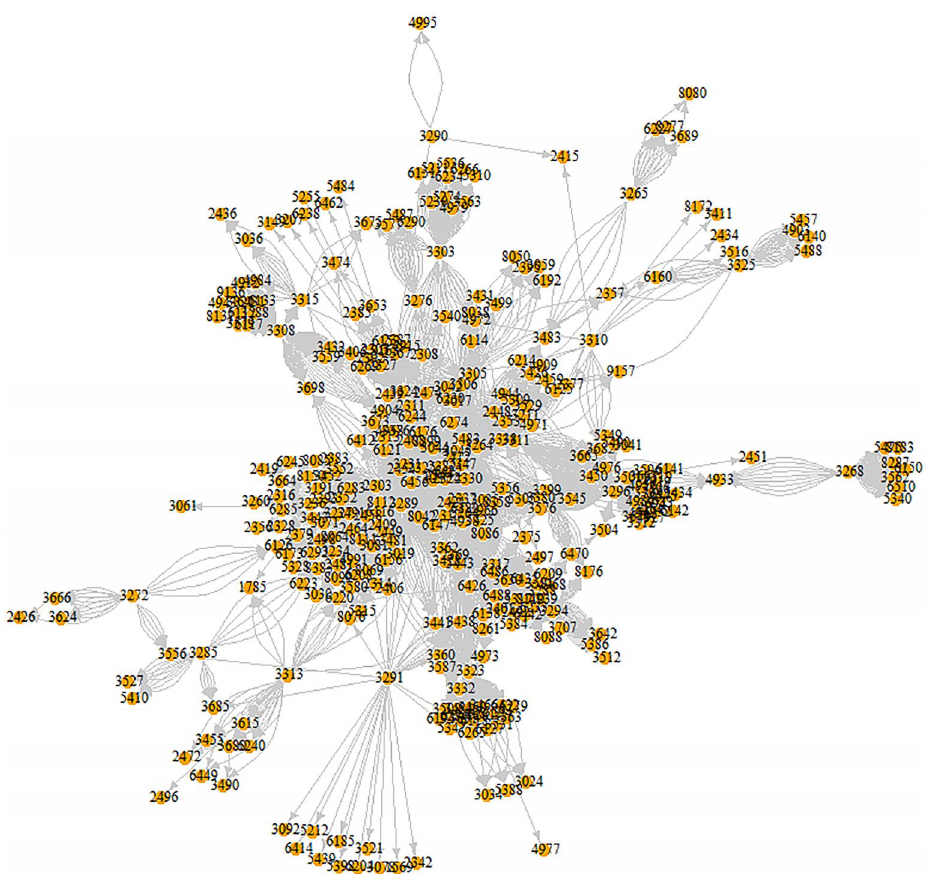
Figure 2. The SC collaboration